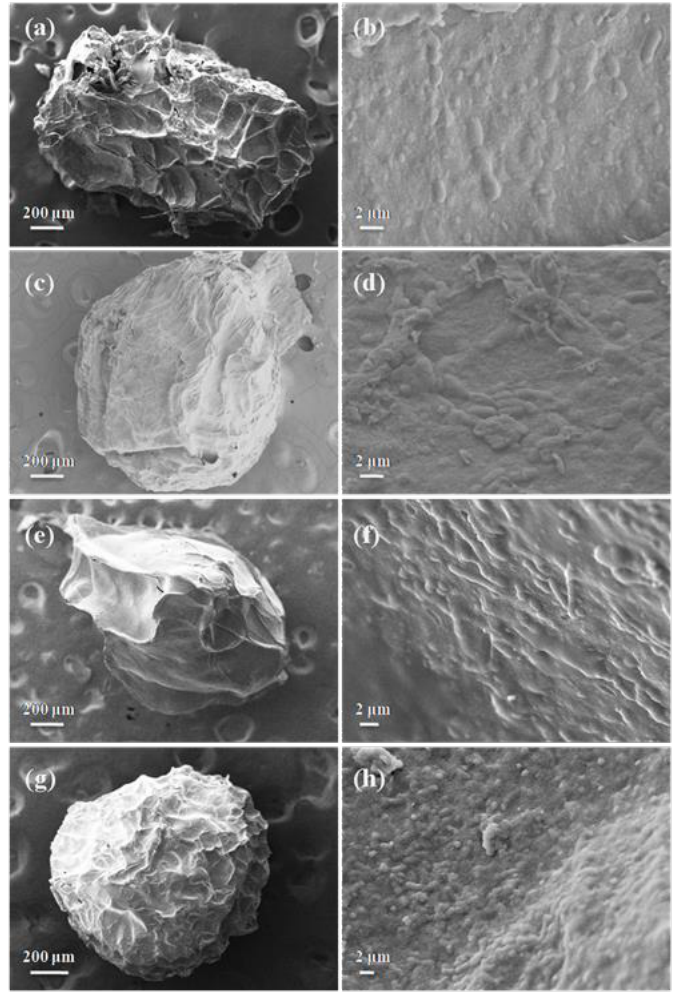
Figure 3. SEM photographs of surface morphology ( a , c , e , g ) and internal structure ( b , d , f , h ) of different microcapsules of SPI-L-P ( a , b ), SPI-F-L-P ( c , d ), SPI-O-L-P ( e , f ), and SPI-O-F-L-P ( g , h ).